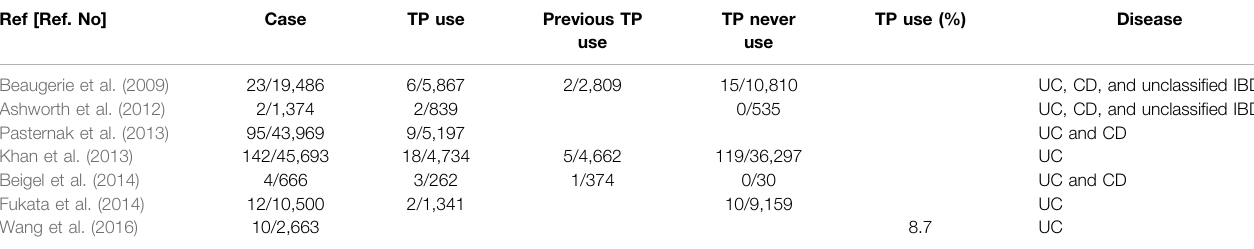
TABLE 2 | Occurrence of lymphoproliferative disorders attributable to thiopurines in patients with IBD. Ref [Ref.